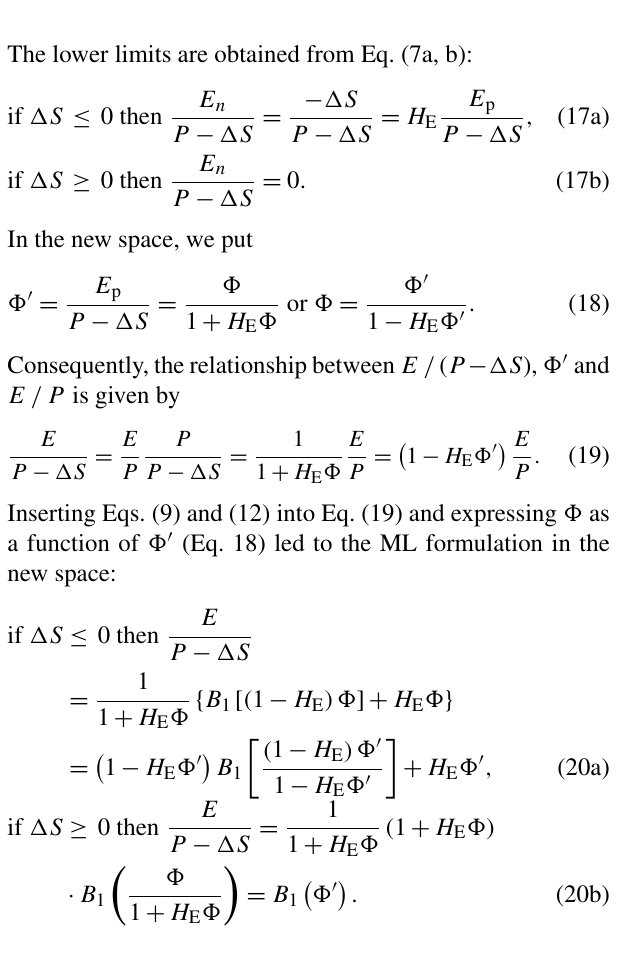
Figure 4. The ML formulation with the Fu–Zhang Eq. (21a, b) in the space [ E p / ( P − (cid:49)S ), E / ( P − (cid:49)S )] for ω = 1.5 and four values of H E . For H E ≥ 0, all curves have a common upper end at (cid:56) (cid:48) = 1 /H E corresponding to E / ( P − (cid:49)S ) = 1. The bold lines indicate the upper and lower limits of the feasible domain shown in grey. For H E ≤ 0, the curve is similar to the one under steady-state conditions.